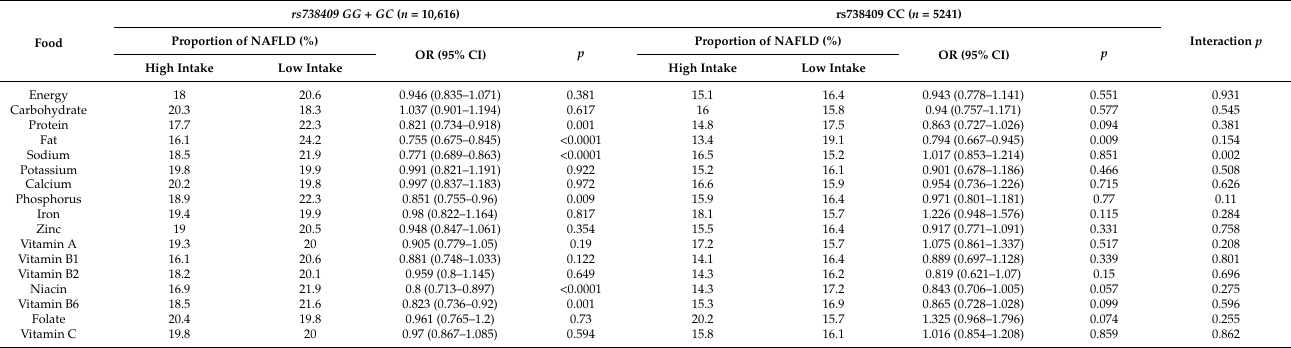
Table 4. Association and interaction between nutrients and the PNPLA3 genotype for the risk of non-alcoholic fatty liver disease (NAFLD) development. Multivariate logistic regression analyses adjusted for age, sex, and smoking were